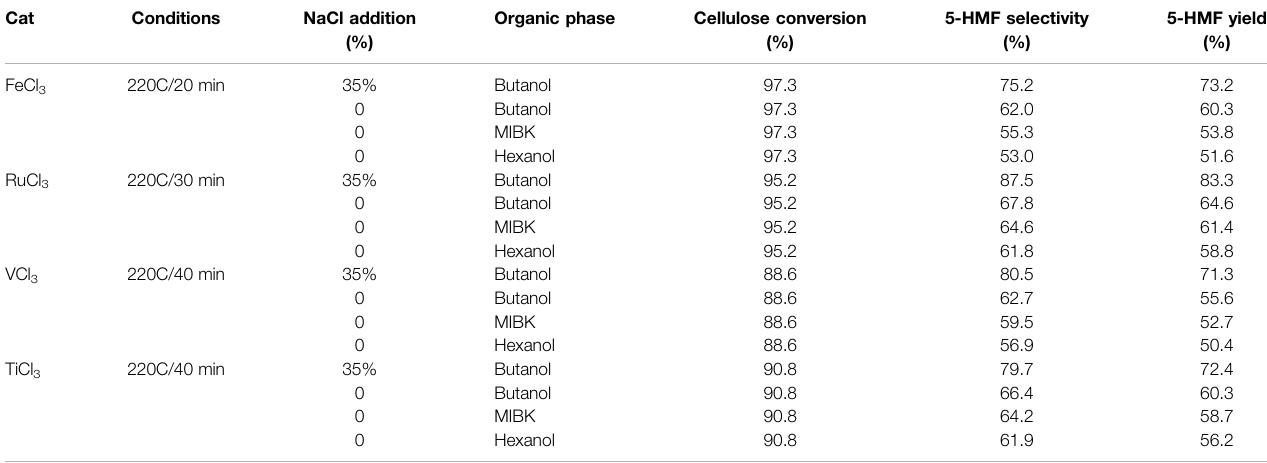
TABLE 1 | Comparison ofthe cellulose to5-HMF catalyzed byFeCl 3 ,RuCl 3 ,TiCl 3 ,and VCl 3 inthe biphasic system (with or withoutNaCl in aqueous phase).(Jinet al.,2021)